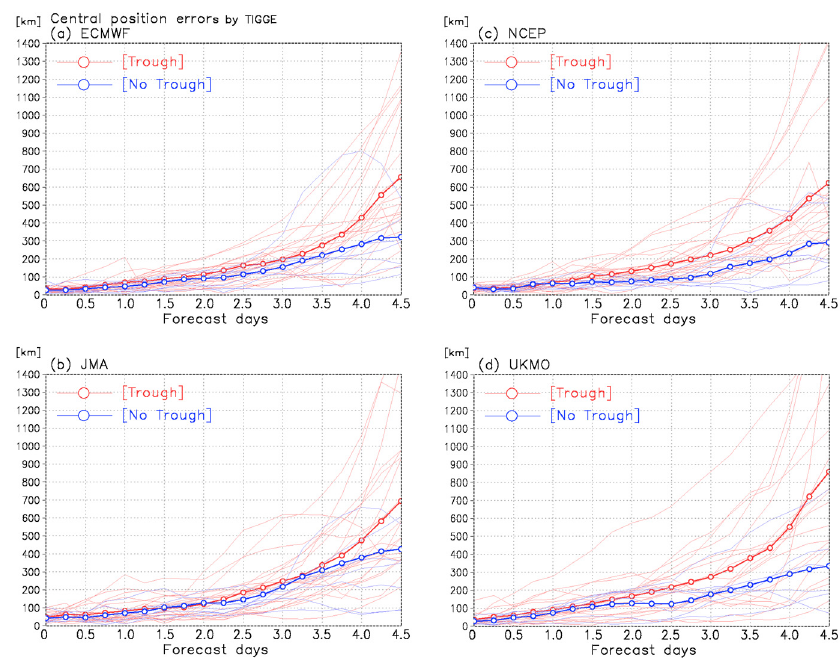
Figure 3. Average central position errors for trough (red thick line) and no trough (blue thick line) cases of Atlantic hurricanes between 2007 and 2019, predicted by the models of ( a ) the European Centre for Medium-Range Weather Forecasts (ECMWF; red), ( b ) the Japan Meteorological Agency (JMA; blue), ( c ) the National Centers for Environmental Prediction (NCEP; purple), and ( d ) the UK Meteorological Office (UKMO; orange), as a function of forecast lead time. Red and blue thin lines show average central position errors for each trough and no trough case.